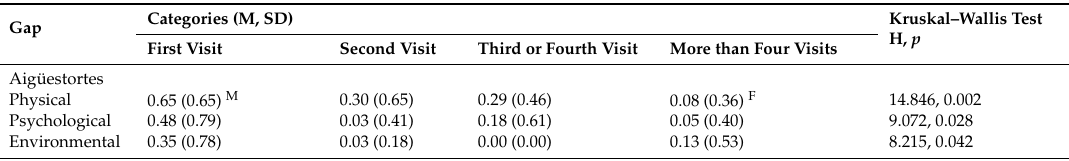
Table A1. Post hoc comparisons for the Gaps between expected benefits and satisfaction according to frequency of visit to Aigüestortes National Park.